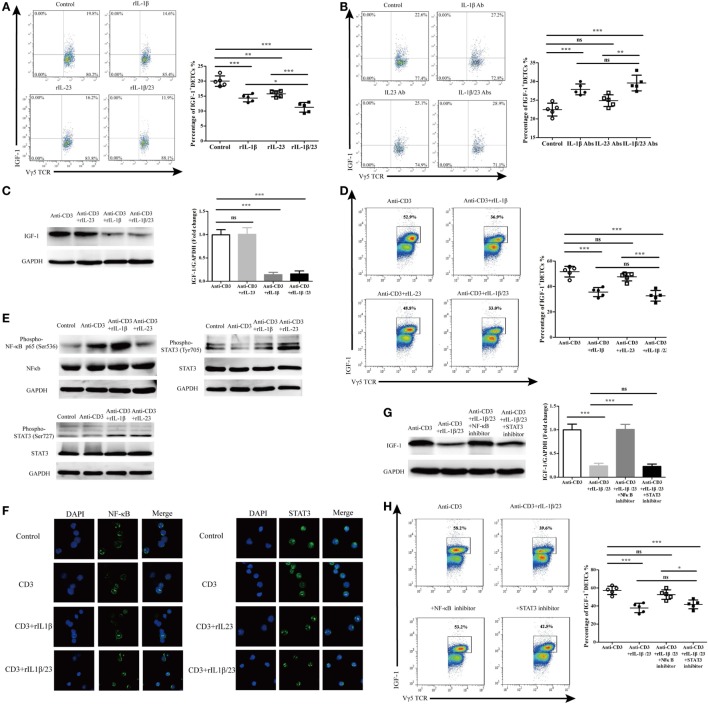
IL-1β rather than IL-23 significantly decreased IGF-1 production by dendritic epidermal T cells (DETCs) in NF-κB-dependent manner. (A) FACS analysis of IGF-1 production in DETCs around wound of wild-type (WT) mice with rIL-1β, rIL-23, or rIL-1β plus rIL-23 treatment in the wound margin for continuous 3 days following excision (4 wounds/mice, 3 mice/group). (B) FACS analysis of IGF-1 production by DETCs around wound of WT mice with IL-1β-neutralizing Ab, IL-23-neutralizing Ab, or IL-1β-neutralizing Ab plus IL-23-neutralizing Ab treatment in the wound margin for continuous 3 days following excision (4 wounds/mice, 3 mice/group). (C,D) eDETCs were rested for 2 weeks without ConA and then co-cultured with rIL-1β, rIL-23, or rIL-1β plus rIL-23 upon anti-CD3ε stimulation for 6 h. The production of IGF-1 in eDETCs was measured by WB (C) and FACS (D). (E,F) eDETCs co-cultured with rIL-1β or rIL-23 upon anti-CD3ε stimulation for 30 min. (E) Expression of phospho-NF-κB p65 (Ser536), total NF-κB p65, phosphor-STAT3 (Ser727), phosphor-STAT3 (Ser705), and total STAT3 was measured by WB. (F) Confocal immunofluorescence was used to check nucleus translocation of NF-κB p65 and STAT3. (G,H) eDETCs co-cultured with rIL-1β plus rIL-23, rIL-1β/rIL-23 plus NF-κB inhibitor (PDTC), or rIL-1β/rIL-23 plus STAT3 inhibitor (S3I-201) upon anti-CD3ε stimulation for 6 h. WB (G) and FACS (H) were performed to analyze IGF-1 expression by eDETCs. Data are representative of three individual experiments. Bars are shown mean ± SD. Data are representative of at least three independent experiments. Error bars represent mean ± SD. One-way ANOVA with Bonferroni comparison test was used to calculated P value (*P < 0.05, **P < 0.01, ***P < 0.001).